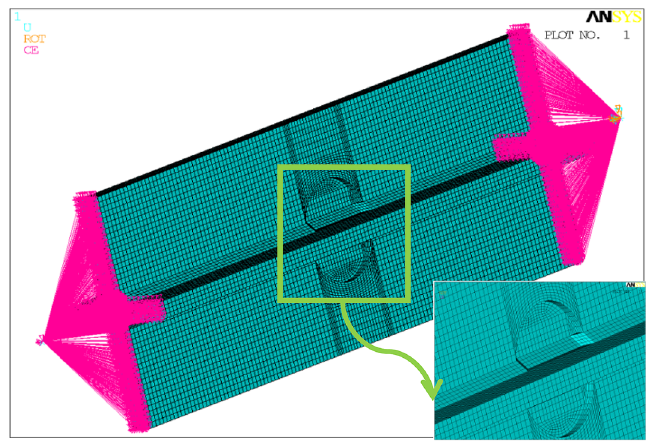
Fig. 4 A finite element model and